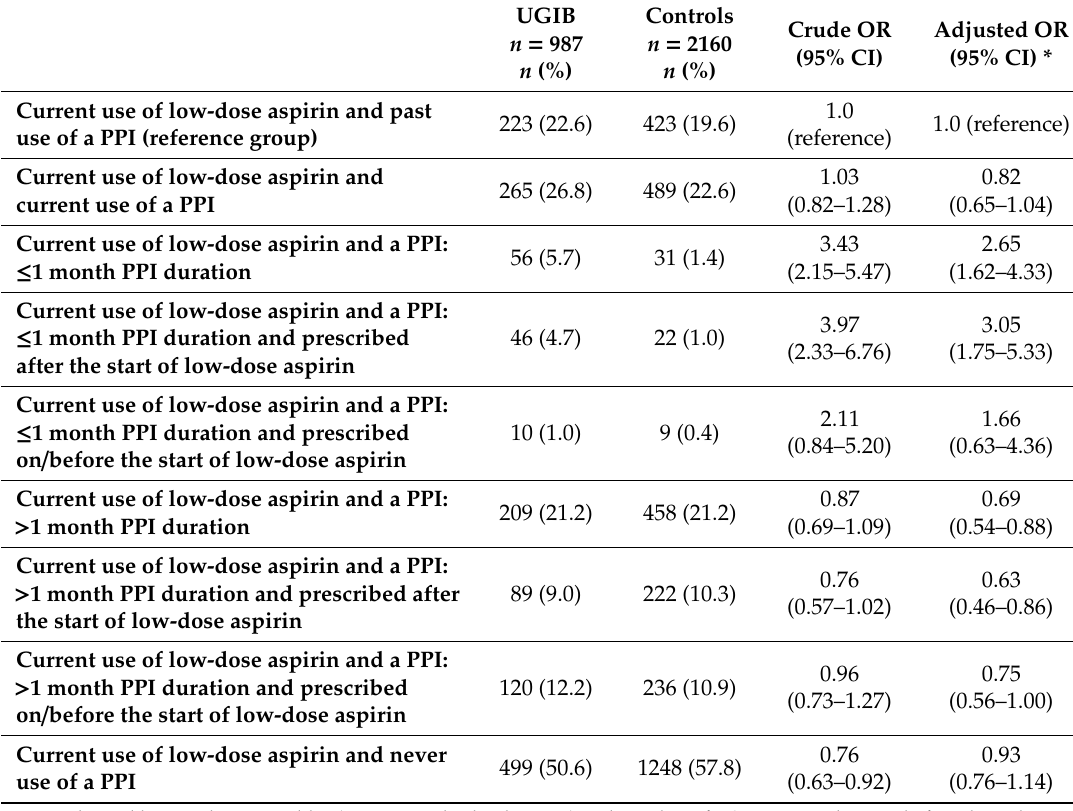
Table 2. ORs (95 CIs) for the association between concomitant use of low-dose aspirin and a PPI and the risk of